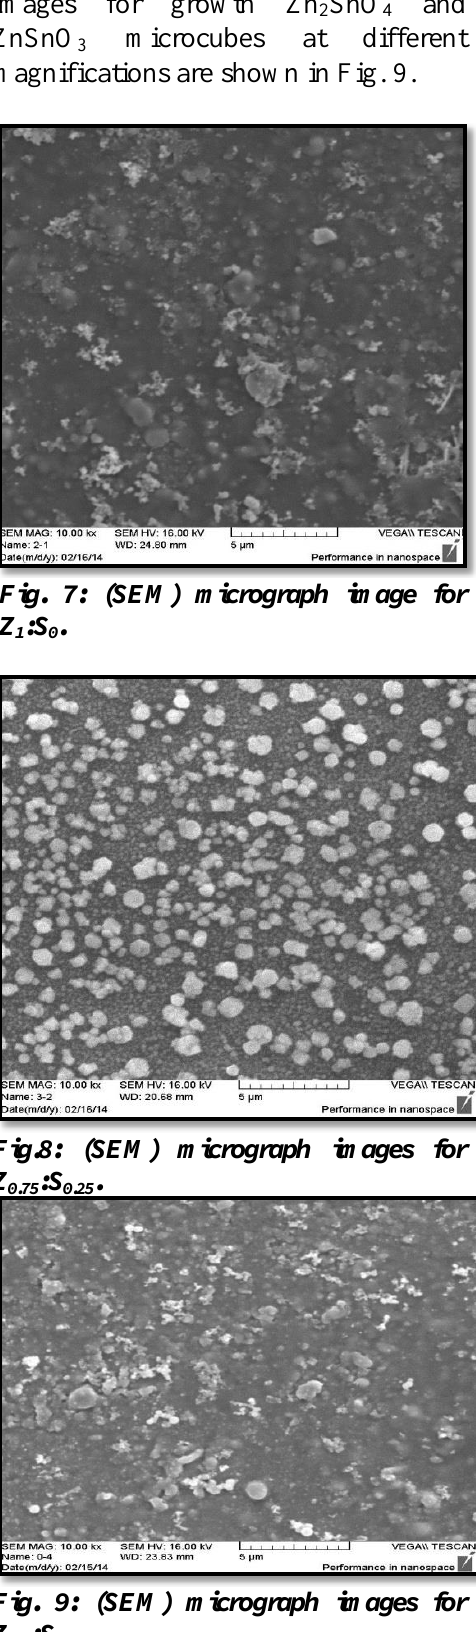
Fig. 9: (SEM) micrograph images for Z :S 0.5 0.5